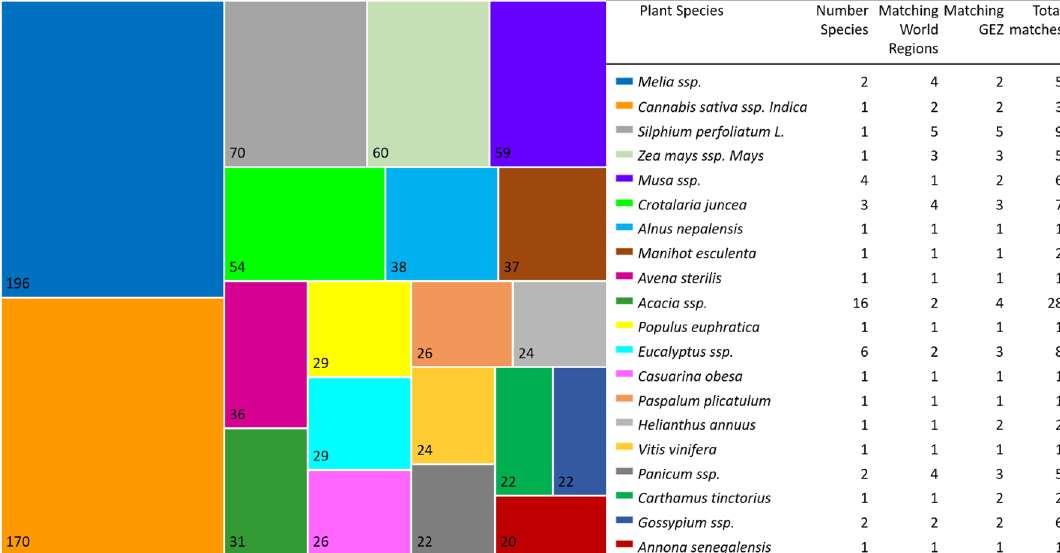
Figure 3. Top biopump soil carbon sequestration potentials, prior to erosion (number in boxes in Mg SOC ha −1 in year 2100) and preliminary compatibility with corresponding number of plant species, matching world regions and global ecological zones (GEZ), as well as total number of matches per target